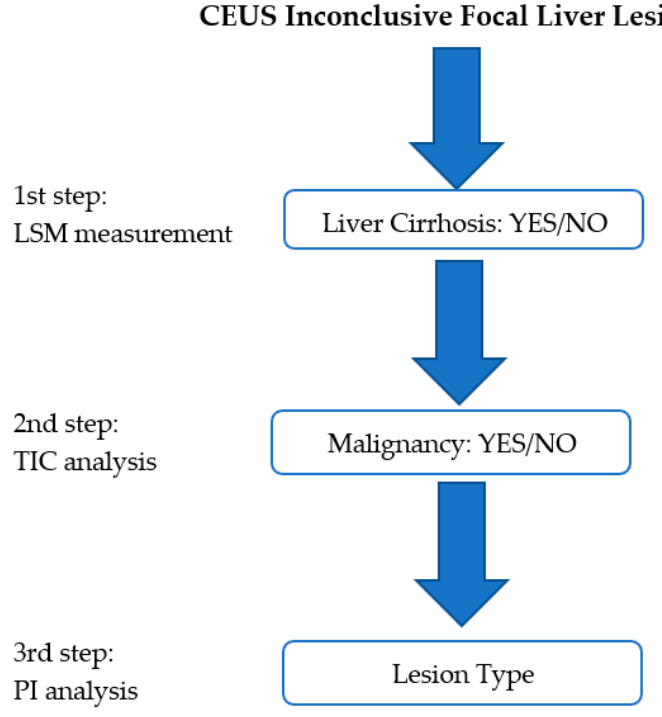
Figure 1. The proposed MPUS steps. The first step consists of liver stiffness evaluation (LSM). In the